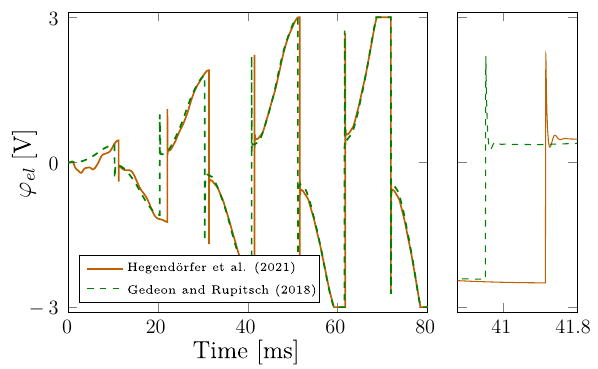
Fig. 17 Comparison of the piezoelectric voltage 𝜑 el in Hegendör- fer et al. [23] against the results reported in Gedeon and Rupitsch (2018) [21] for the SSHI circuit and a unimorph electromechanical